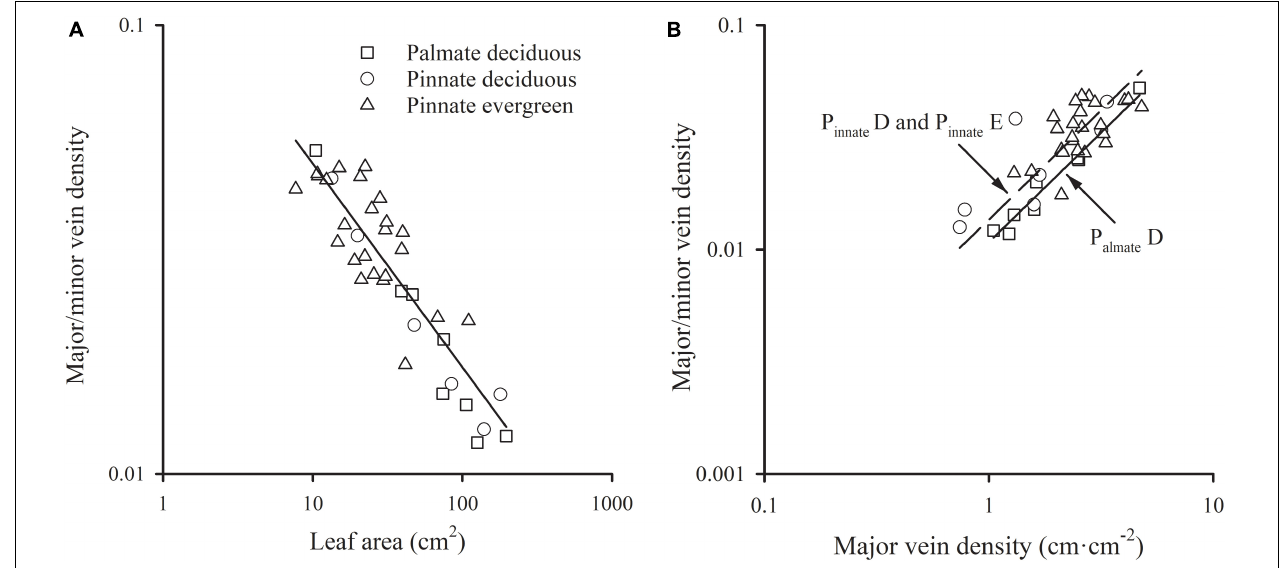
FIGURE 3 | The relationships of the ratio of major to minor vein density with leaf area (A) and the major vein density (B) . For abbreviations, see Figure 1